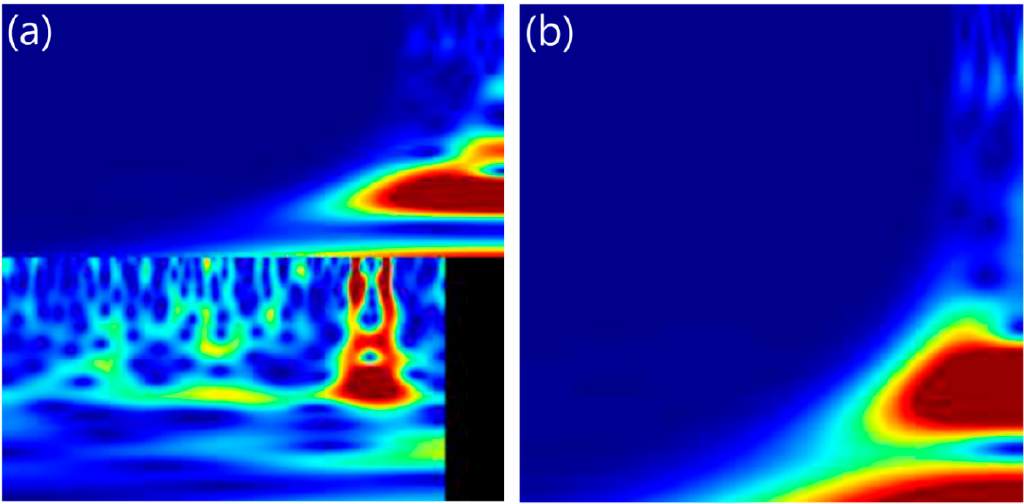
Figure 3. Examples of input images for the CNN training: ( a ) rainfall scalogram (upper half image) and velocity scalogram (lower half image). To keep the date alignment, the velocity scalogram is zero-padded; ( b ) rainfall scalogram only. The shown data are related to the extreme event occurred on 29 October 2018 in the Perarolo area. Clearly, since they are input images for CNN, labels, and color bars are not shown.